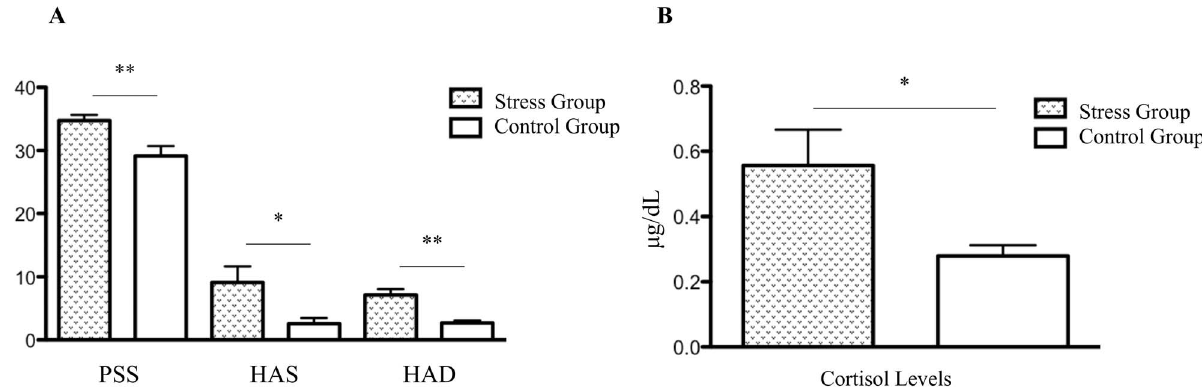
Figure 1. Clinical characteristics of the cohort. ( A): Perceived Stress Scale (PSS), Hamilton Anxiety Scale (HAS); Hamilton Depression Scale (HAD) and (B): Salivary Cortisol levels of the stressed and control groups. **P , 0.01; *P , 0.05.